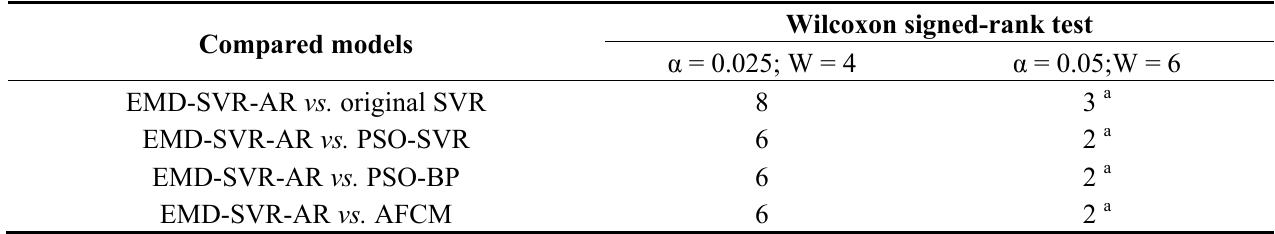
Table 4. Wilcoxon signed-rank